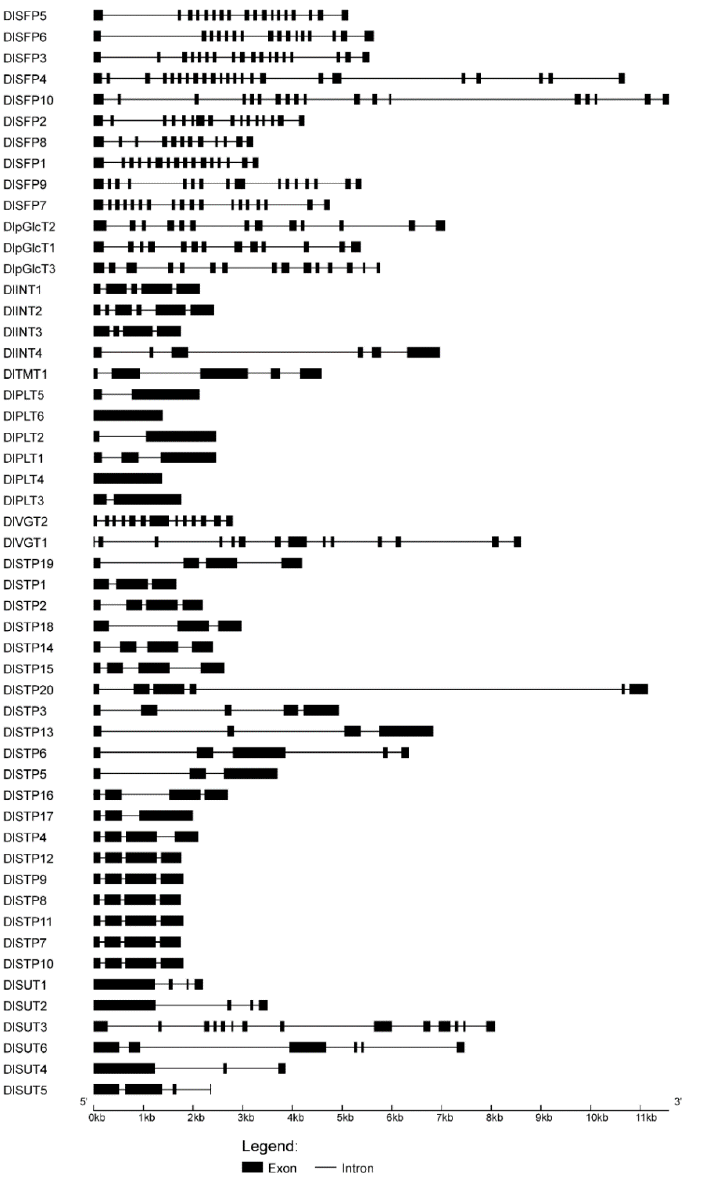
Figure 4. Gene structures of 52 DlSTs.